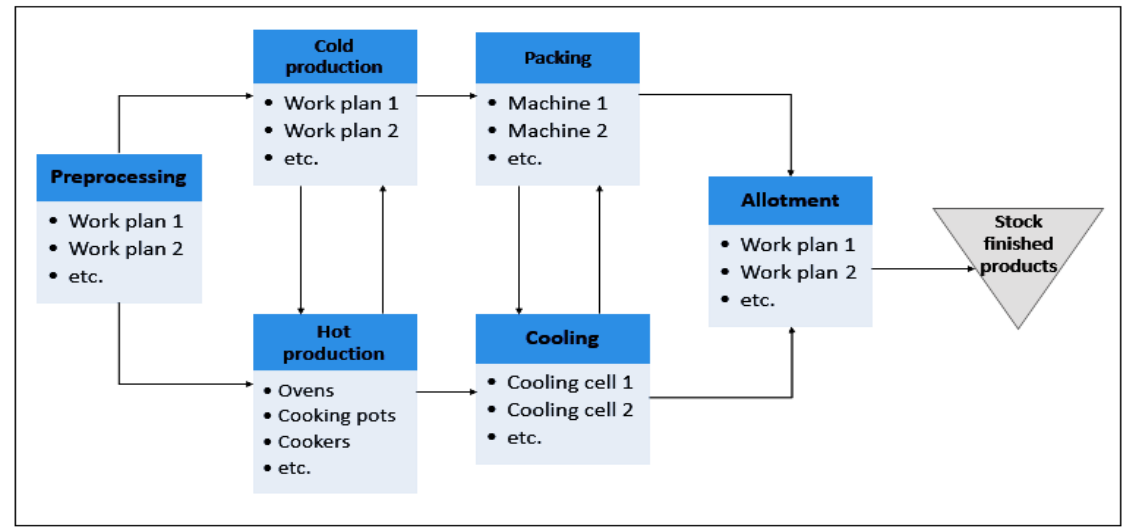
Figure 2. Representative scheme of the meal production